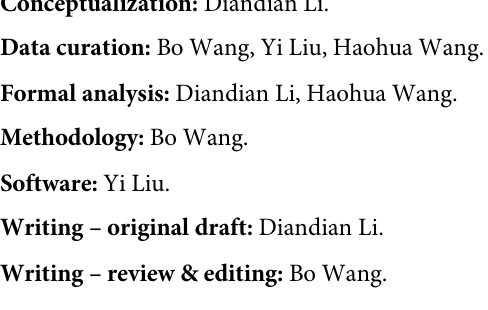
S1 Table. Quality assessment for each study. S2 Table. Meta-analysis of the overall prevalence of OSA in DPLDs based on hypopnea scoring